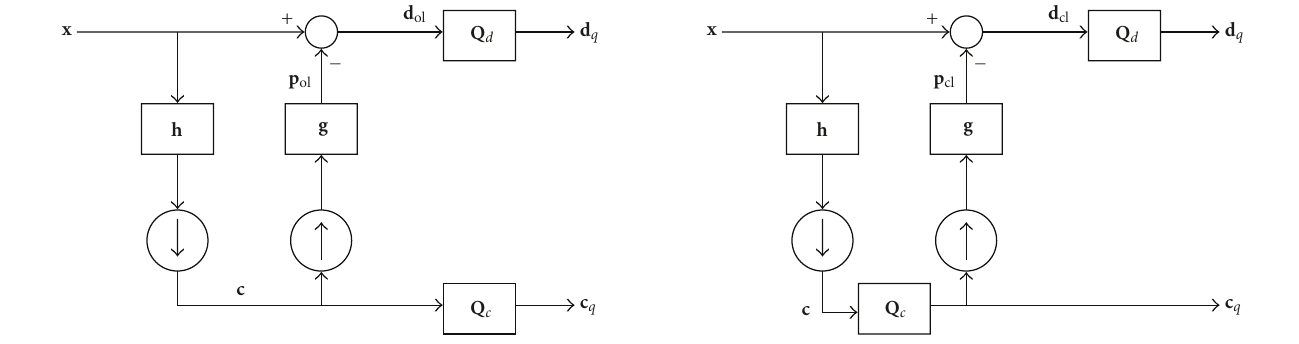
Figure 1: Open-loop Laplacian pyramid structure with one decom- position level.